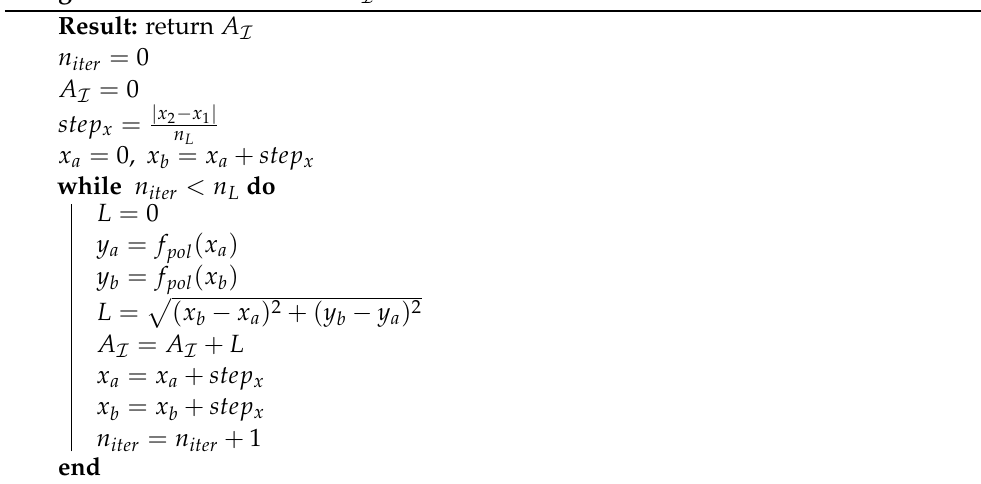
Algorithm 1: Calculation of A I in